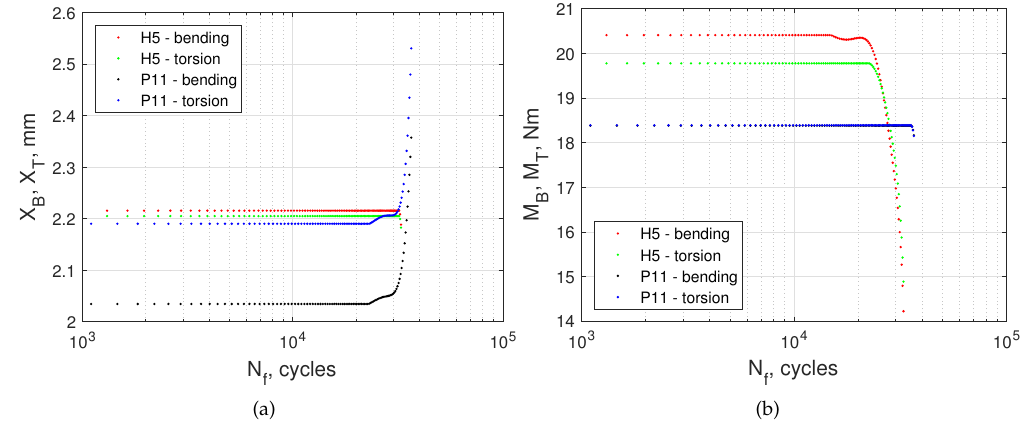
Figure 17. ( a ) Change in the fatigue testing machine lever displacement throughout the entire duration of the specimen test. Red and green correspond to the specimen subjected to kinematic loading, whereas black and blue correspond to the fatigue testing machine lever displacement for the specimen subjected to dynamic loading, ( b ) The moments load the specimen throughout the entire test period. Red and green correspond to the specimen subjected to kinematic loading, whereas black and blue correspond to the specimen subjected to dynamic